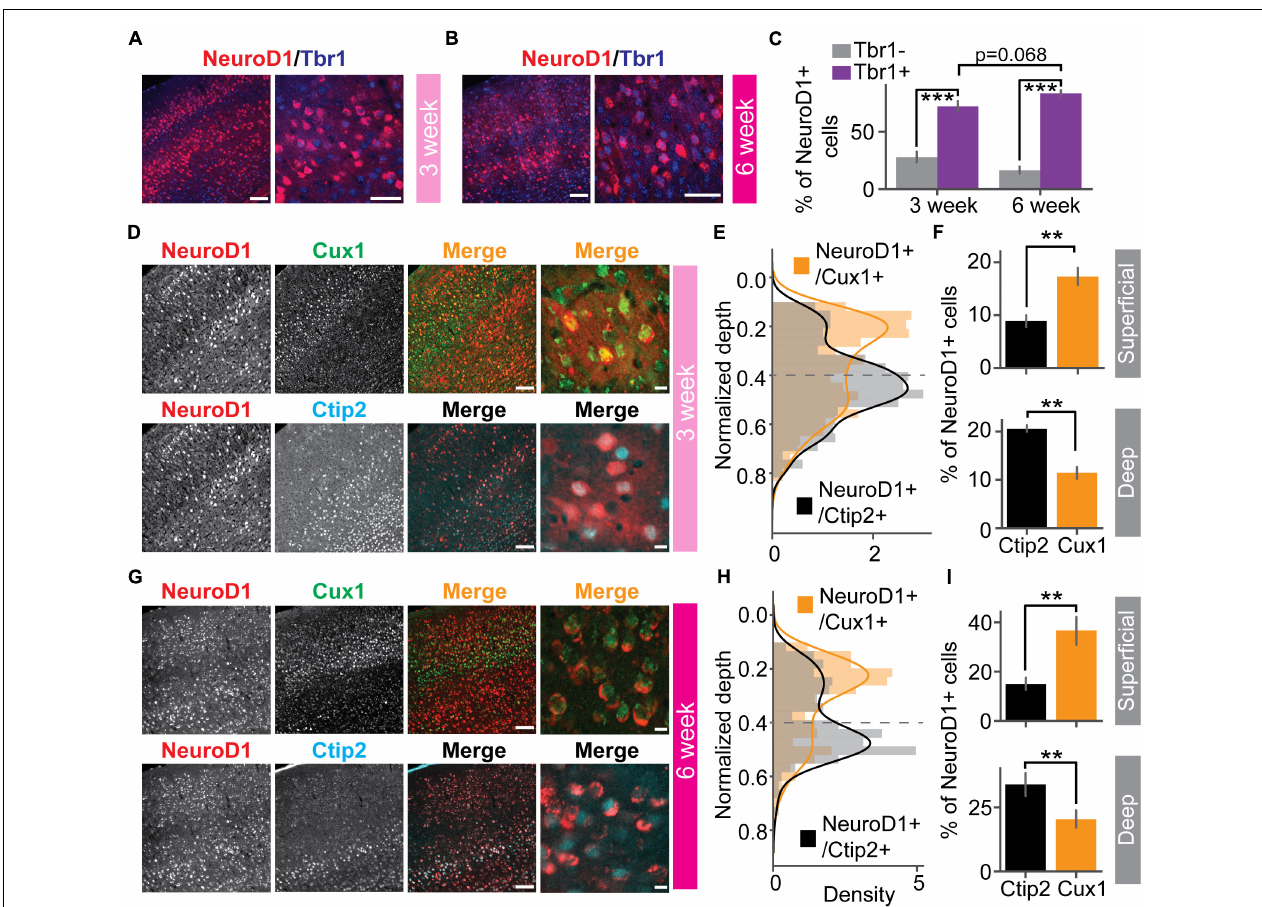
FIGURE 2 | Reprogrammed cells acquire superficial and deep cortical layer identities. (A) NeuroD1 positive cells stained with cortical neuron marker Tbr1 at 3 weeks after the viral injection. Scale left : 100 µ m, Scale right : 50 µ m. (B) Same as (A) but at 6 weeks after the viral injection. Scale left : 100 µ m, Scale right : 50 µ m. (C) Quantification of Tbr1 positive cells out of NeuroD1 positive cells. Tbr1- vs. Tbr1+: N 3 week = 2 mice, 12 slices, p = 1.23 × 10 − 4 ; N 6 week = 4 mice, 23 slices, p = 1.51 × 10 − 8 . 3 week vs. 6 week: p = 0.068. Mann-Whitney U -test with Bonferroni correction. (D) A representative slice showed that NeuroD1 positive cells co-stained with superficial layer marker Cux1 (top row), deep-layer marker Ctip2 (bottom row) at 3 weeks after the viral injection. The NeuroD1 image at the top and bottom row is the same. Scale left : 100 µ m, Scale right : 10 µ m. (E) Probability density of counts of NeuroD1+/Cux1+ cells and NeuroD1+/Ctip2+ cells across normalized cortical depths at 3 weeks after the viral injection. 0 indicates the brain surface. The dashed line indicates superficial and deep layer separation. (F) Percentages of Cux1+/NeuroD1+ and Ctip2+/NeuroD1+ cells in the superficial layers (top) and the deep layers (bottom) at 3 weeks after the viral injection. N superficial = 2 mice, 4 slices, p = 3.06 × 10 − 3 . N deep = 2 mice, 4 slices, p = 2.54 × 10 − 3 . Mann-Whitney U -test with Bonferroni correction. (G) Same as (D) but at 6 weeks after the viral injection. (H) Same as (E) but at 6 weeks after the viral injection. (I) Same as (F) but at 6 weeks after the viral injection. N superficial = 3 mice, 7 slices, p = 3.06 × 10 − 3 . N deep = 3 mice, 7 slices, p = 2.33 × 10 − 3 . Mann-Whitney U -test with Bonferroni correction. ** p < 0.05 and *** p < 0.001. Data are represented as mean ±